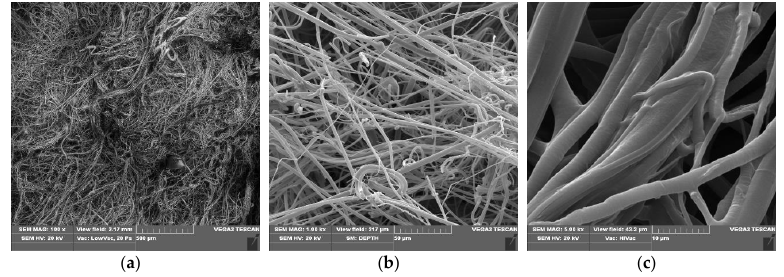
(c) Figure 1. SEM images of PLA nonwoven, magnification: (a) 100×, (b) 1000×, (c) 5000×. (a) (b) (c) Figure 2. SEM images of PLA-Cu 0 (10), magnification: (a) 100×, (b) 1000×, (c) 5000×.